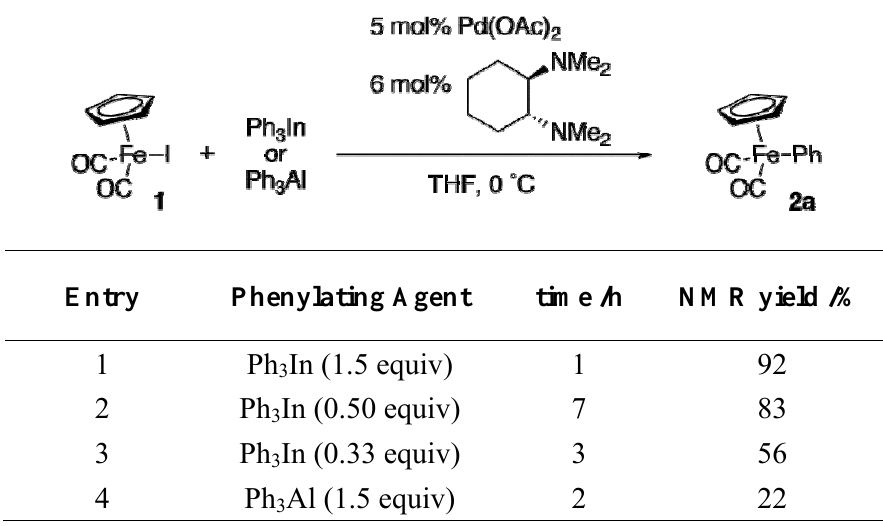
I] with Triphenylindium or 2